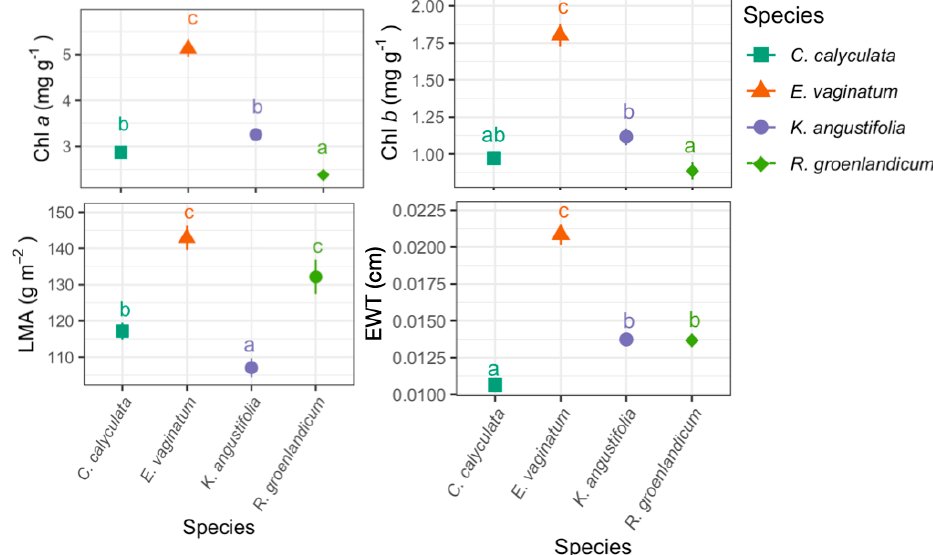
Figure 3. Mean ( ± standard error) functional traits per species. Sample size for E. vaginatum = 23, K. angustifolia = 24, C. calyculata = 24 and R. groenlandicum = 23. LDMC: leaf dry matter content, Chl: chlorophyll, LMA: leaf mass per area, and EWT: equivalent water thickness. See Figure 1 for description of site acronyms. Letters indicate significant differences among species ( p ≤ 0.05).